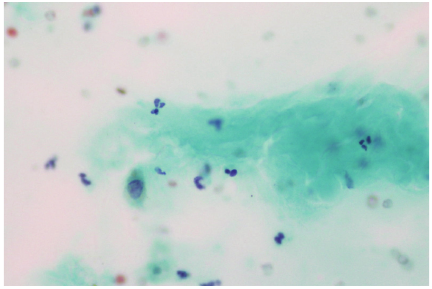
Figure 2: FNAC showing colloid.